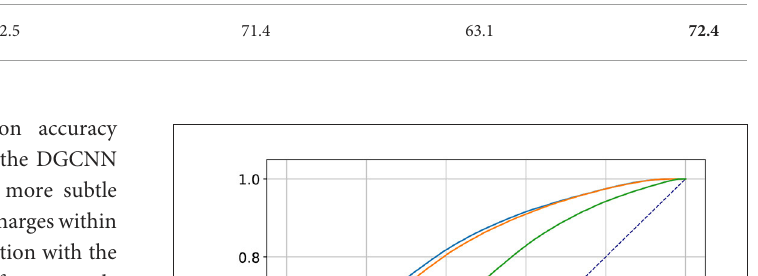
trees were applied on these engineered features using the XGBoost algorithm. The XGBoost model hyperparameters were tuned using grid search, yielding a test accuracy of 71.4% which represented an 8.9% improvement over the baseline information. The β 2, β 4, β 5, number of hits and consecutive